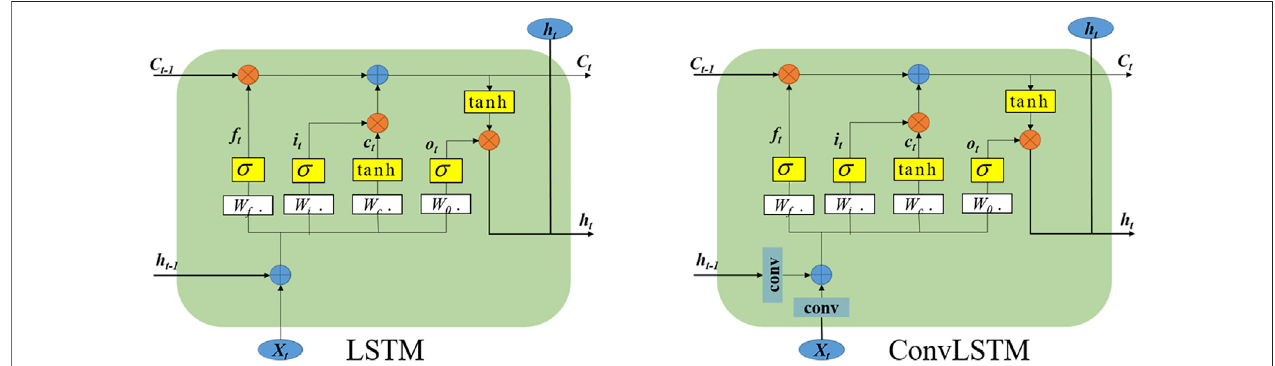
FIGURE 4 | The structure of LSTM and